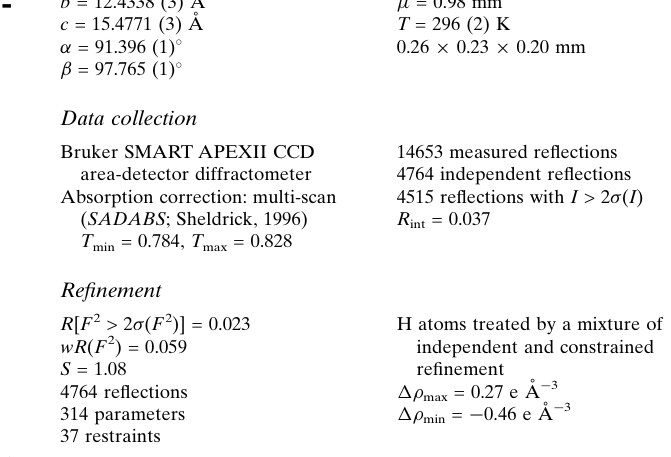
two bidentate chelating 4-methylbenzoate ligands, two N atoms from two imidazole ligands and one water molecule in a distorted pentagonal bipyramidal geometry. Intermolecular molecule and the carboxylate O atoms of 4-methylbenzoate lead to an infinite chain. These chains are further self- hydrogen bonds between the imidazole ligands and carboxyl- ate groups. One of the imidazole ligands is disordered over two positions with site-occupancy factors of 0.737 (4) and 0.263 (4).